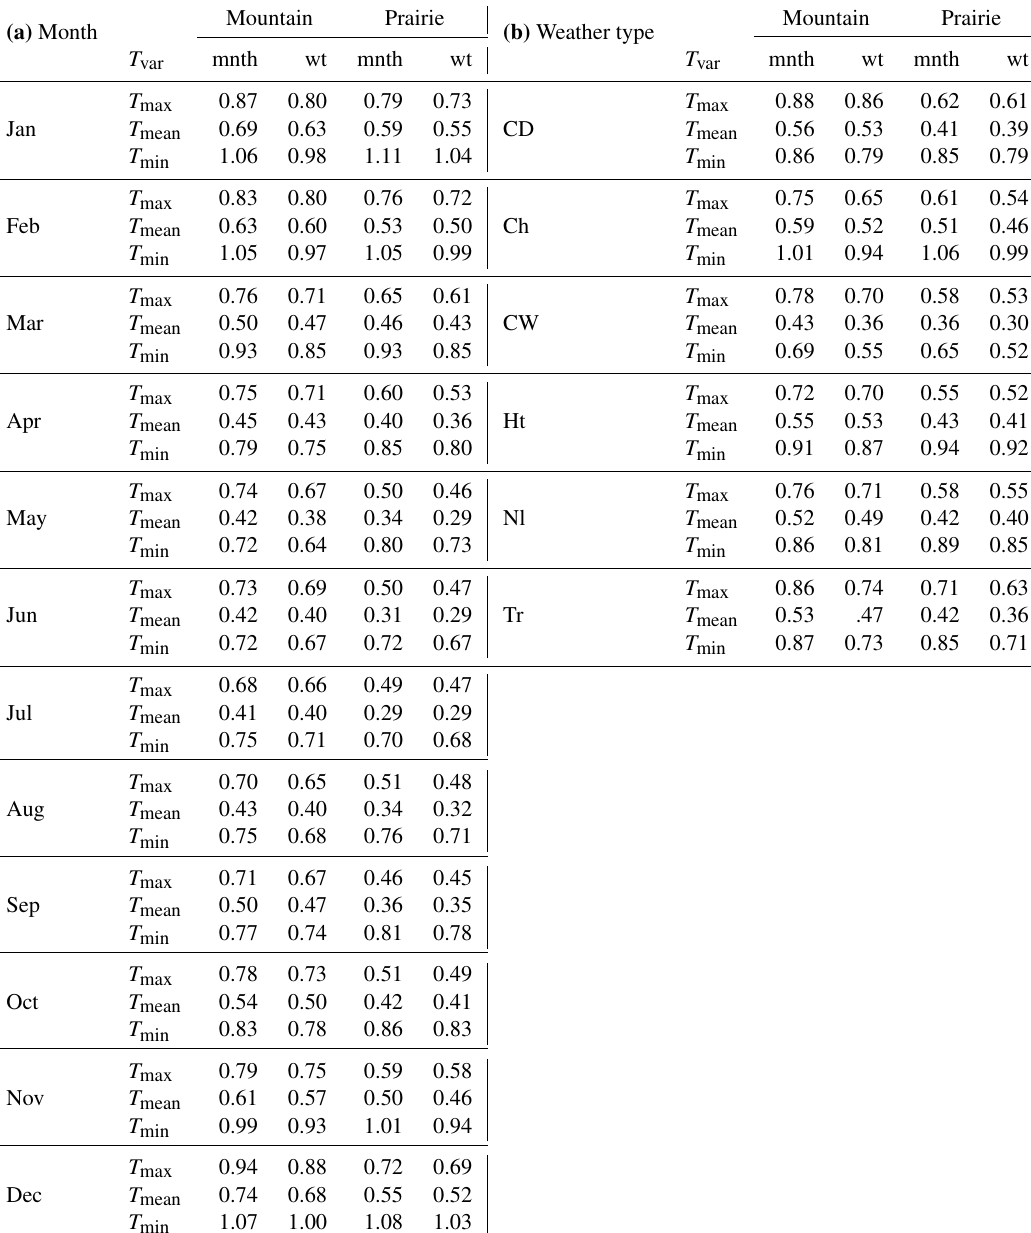
Table 5. Estimated gap-filling errors shown as mean absolute temperature errors ( ◦ C) calculated as the difference between actual temperature and temperature estimated using the most highly correlated station by month (mnth) and weather type (wt), shown for each (a) month and (b) weather type for prairie and mountain